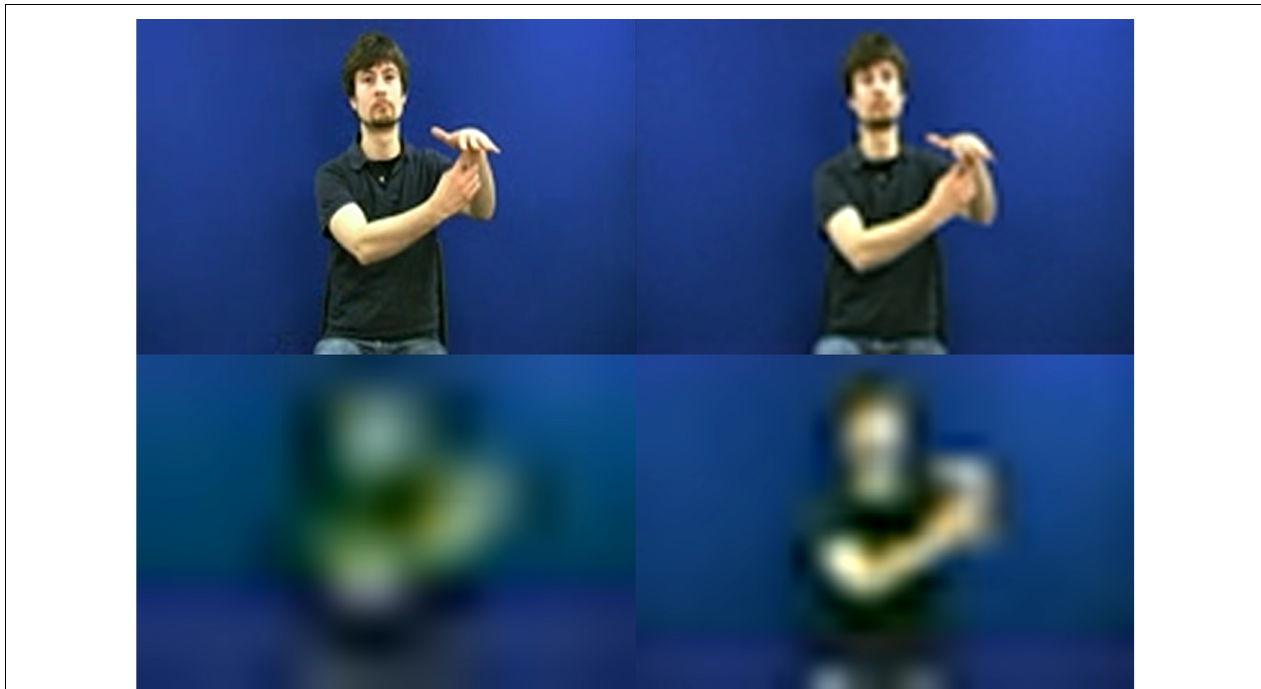
FIGURE 1 | Example of one lexical sign at resolutions R2–R5 with decreasing resolution clockwise from upper left. R2 (180 × 120 pixels); R3 (90 × 60 pixels); R4 (24 × 16 pixels); R5 (12 × 8